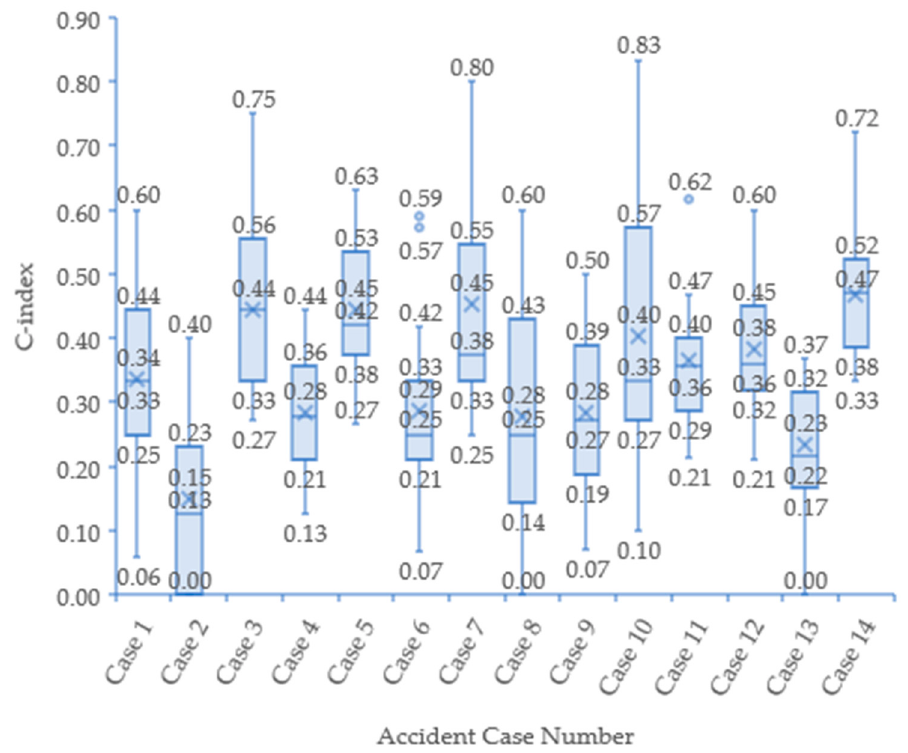
Figure 5. Data distribution of C-index calculation results among Group A. ‘ × ’ in the figure represents the average value.